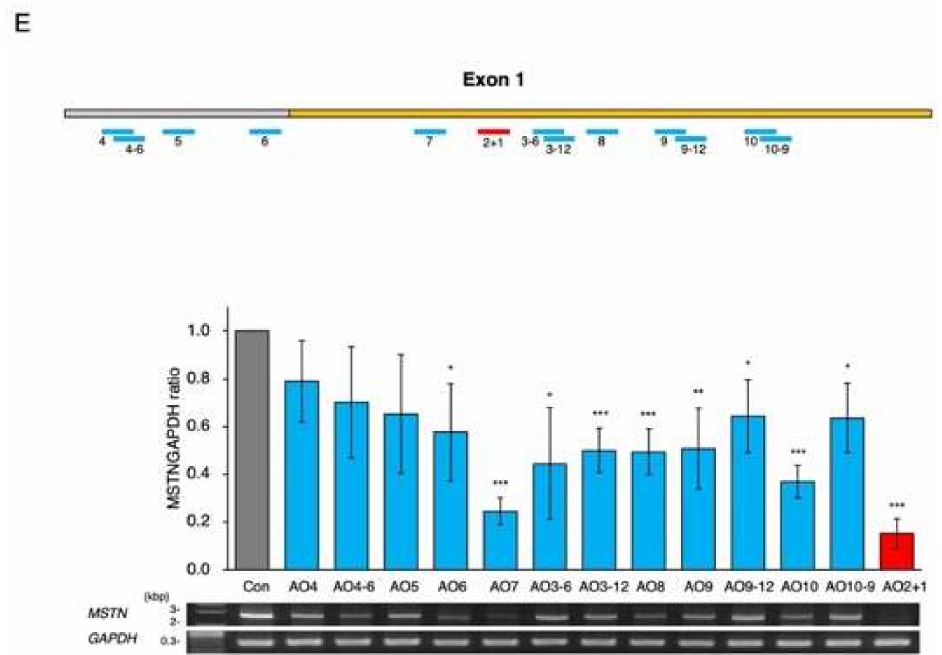
Figure 2. Screening of ASOs that decrease MSTN mRNA levels. ( A ) As the first step of screening, three 18-mer ASOs (AO1–3) complementary to the splicing enhancer sequence of exon 1 were synthesized and added to the culture medium of CRL-2061 cells. Mature MSTN mRNA was RT–PCR amplified, and the MSTN / GAPDH ratio was calculated. Electrophoretograms of the RT–PCR-amplified products are shown ( bottom ), and the MSTN / GAPDH ratios are shown as bars ( top ). All three ASOs decreased the ratio, and AO2 decreased the ratio to approximately 0.2. ( B ). Illustration of the locations of the designed ASOs. To find the ASO that most effectively decreased the MSTN / GAPDH ratio, another nine ASOs (five (green bar) and four (red bar) ASOs in the second and third screenings, respectively) were synthesized around AO2 (blue bar). The nucleotide sequences are described below, and the sequence complementary to AO2 is colored blue. ( C ). In the second screening, five ASOs (AO2+3, AO2+6, AO2+9, AO2–3, and AO2–6) were synthesized and examined for their ability to